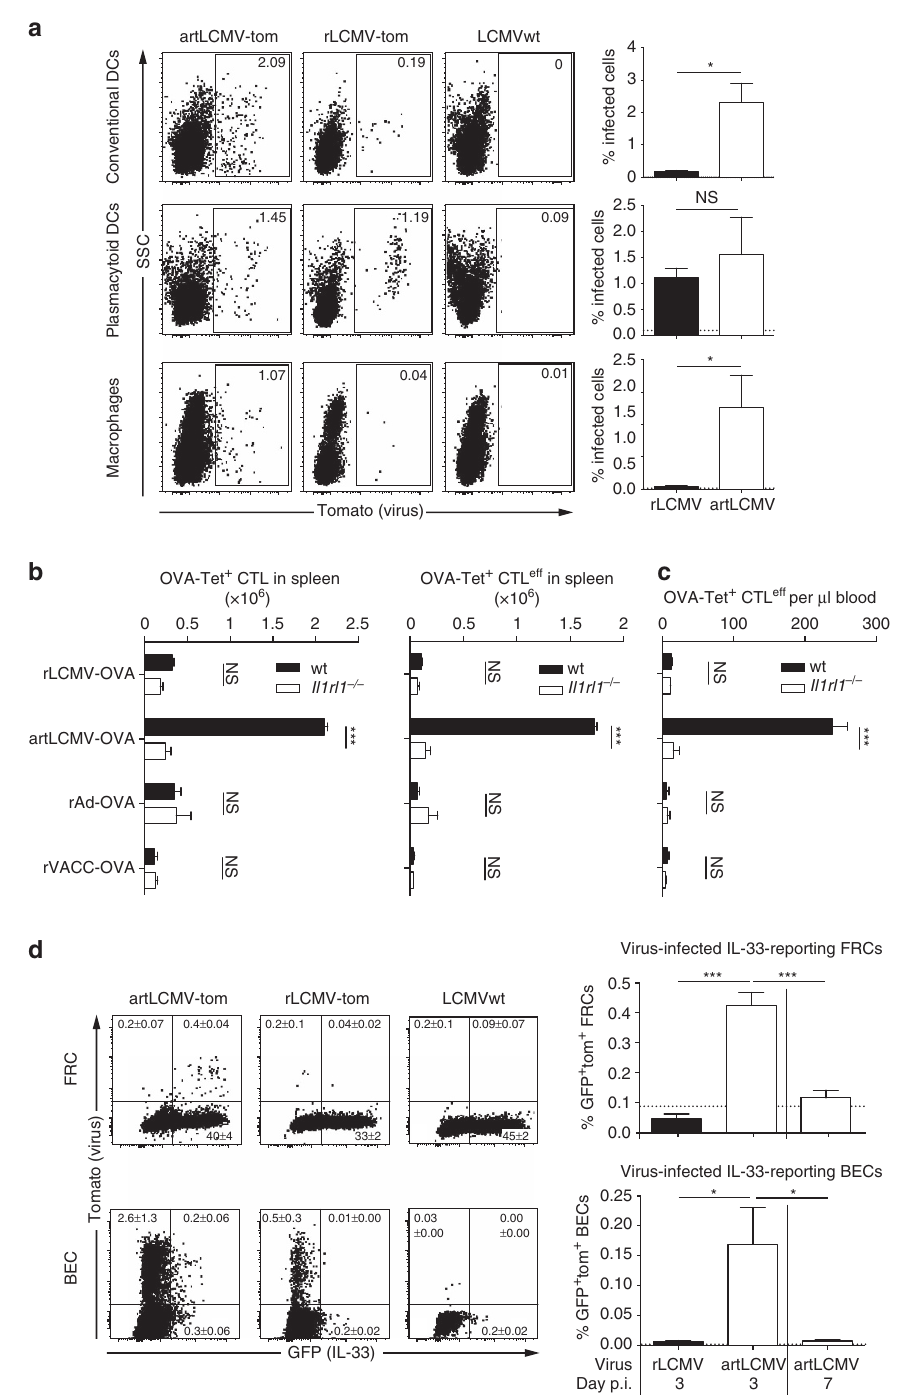
Figure 5 | artLCMV infects DCs and IL-33-expressing stromal cells to trigger IL-33-driven CTL expansion. ( a ) We infected C57BL/6 mice with artLCMV-tom, rLCMV-tom or LCMVwt and quantified virus-infected tomato-reporting conventional dendritic cells (lineage (cid:2) CD11c hi B220 (cid:2) ), plasmacytoid DCs (pDCs; lineage (cid:2) CD11c int B220 þ ) and macrophages (lineage (cid:2) CD11b þ Ly6G (cid:2) ) in spleen on d4. Representative FACS plots (left) and quantifications (right) are shown. Bars represent the mean þ s.e.m. of four mice per group. N ¼ 2. ( b , c ) Wt and ST2-deficient ( Il1rl1 (cid:2) / (cid:2) ) mice were infected with artLCMV-OVA, rLCMV-OVA, rAd-OVA or rVACC-OVA. Spleens ( b ) were analysed on d9, peripheral blood ( c ) on d8. OVA-tetramer-binding total CD8 þ Tcells ( b , left), as well as OVA-tetramer-binding CTL eff (Klrg1 þ CD127 (cid:2) ) in spleen and blood were enumerated by FACS ( b right, c ). Bars represent the mean þ s.e.m. of four mice per group. N ¼ 2. ( d ) FACS analysis of splenic fibroblastic reticular cells (FRC) and blood endothelial cells (BEC) (gated as outlined in Supplementary Figs 1 and 4c) from hemizygous IL-33 reporter mice ( IL-33 gfp/wt ) on d3 and d7 after infection with artLCMV-tom, rLCMV-tom or LCMVwt (control). Representative FACS plots are shown. Quadrant statistics and quantifications of IL-33-expressing (GFP þ ) viral vector-infected (tom þ ) cells (bar graphs) are shown as mean þ s.e.m. of four mice per group. N ¼ 2. Horizontal dashed lines show technical backgrounds of uninfected controls. Data in a – c were analysed by unpaired two-tailed Student’s t -test (( b , c ) with Bonferroni correction) and data in d were analysed by one-way ANOVA